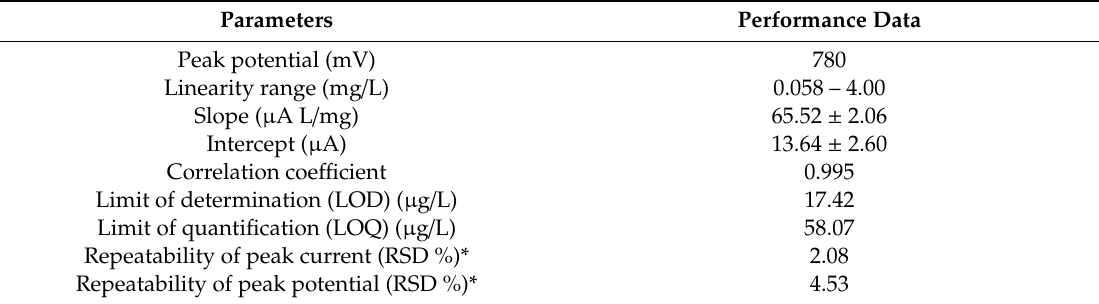
Table 1. Analytical performance data for the determination of oxyclozanide by SWSV using CPE at pH 2 BR bu ff er solution.